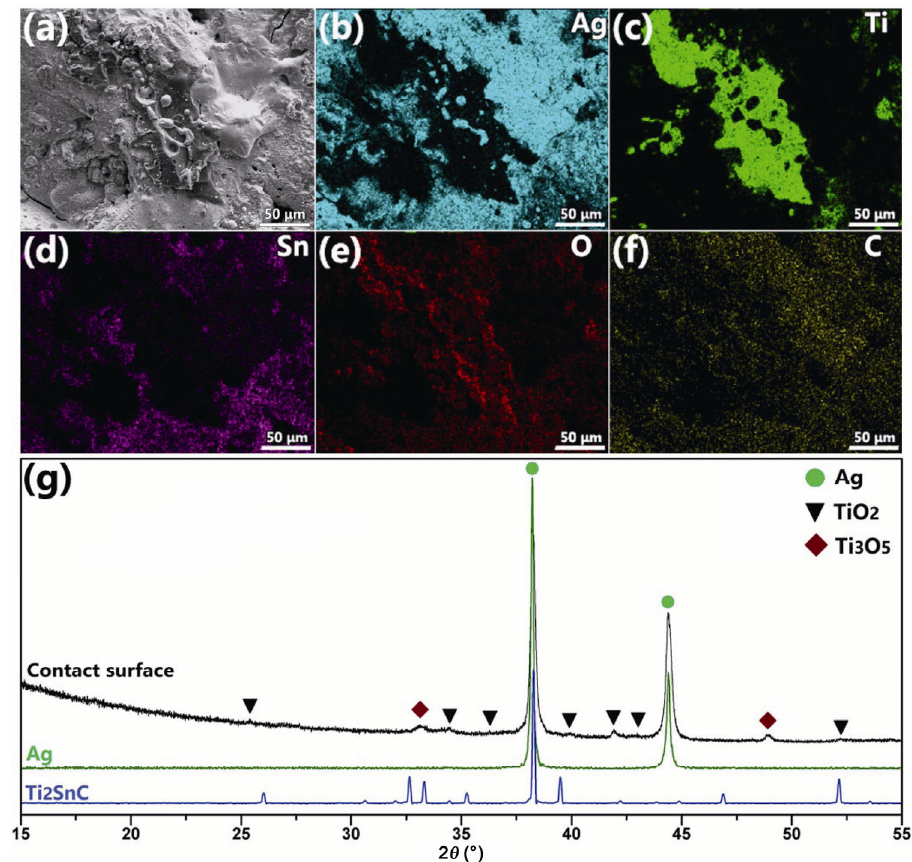
Fig. 13 Element distribution on the surface of the eroded Ag/10TSC contacts after electric arc discharging. (a) SEM image. (b–f) Distribution of the Ag, Ti, Sn, O, C elements in sequence. (g) Phase composition on the surface of the eroded Ag/10TSC contacts after the electric arc